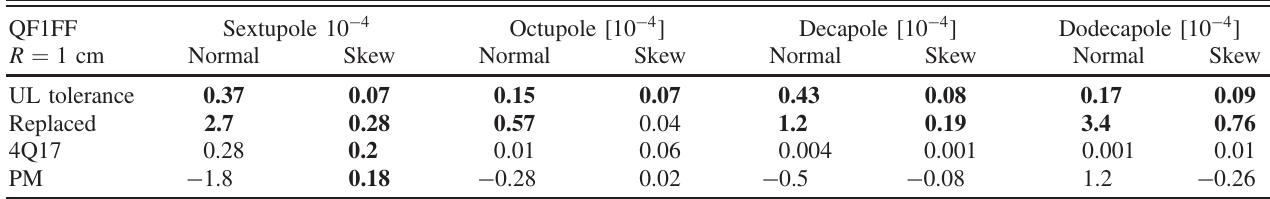
TABLE IV. Comparison between the evaluated tolerance for the ATF2 ultralow β (cid:1) lattice, the measured multipole components of the previously installed QF1FF, the current QF1FF (4Q17) [31], and the expected components of the permanent magnet (PM) [32] at a radius equal to 1 cm for the sextupole, octupole, decapole, and dodecapole components of